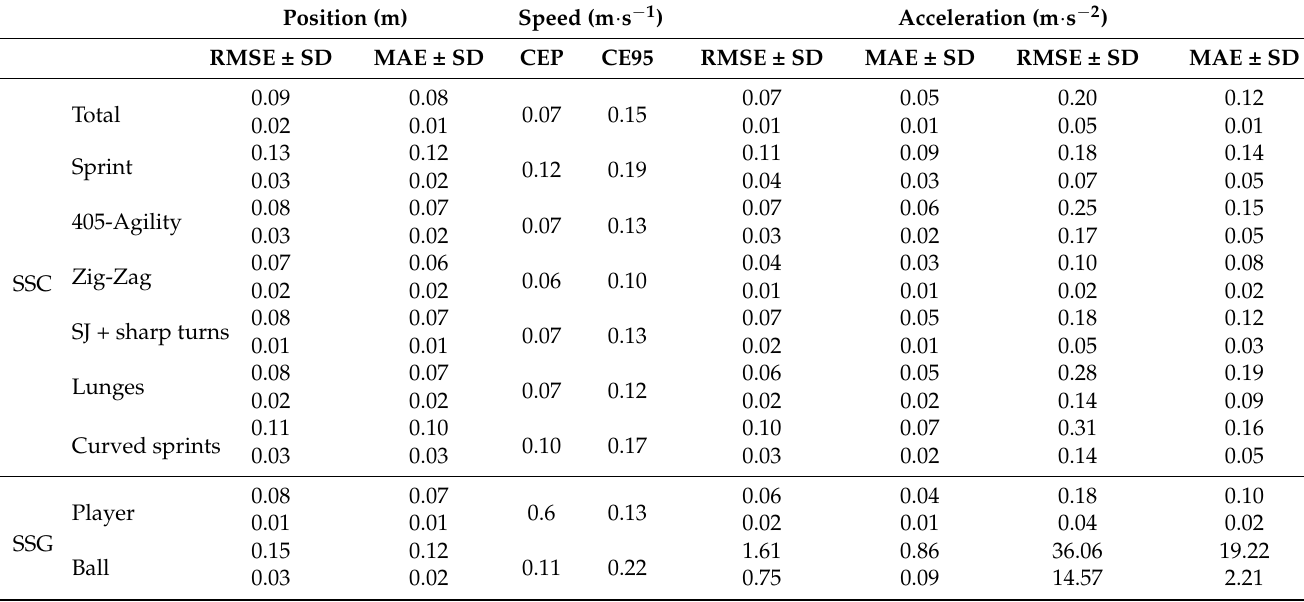
Table 2. Position, speed and acceleration errors measured for SSC and SSG. For each category, root mean square error (RMSE) and mean absolute error (MAE) as well as their standard deviation (SD) is shown. CEP indicates the median position error, CE95 the 95th percentile of error values.